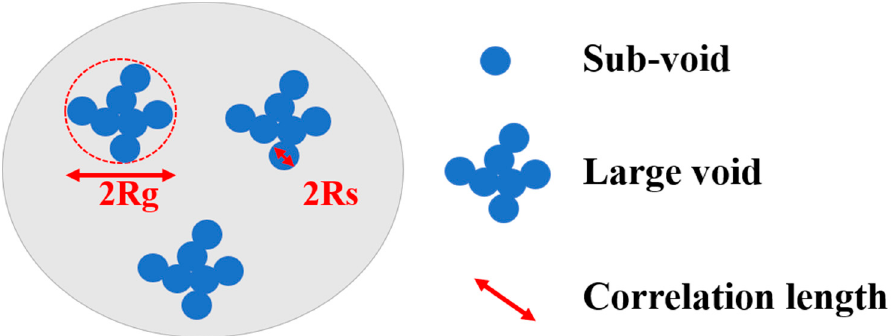
Figure 7. Voids composed of large voids with a radius of gyration for the entire void, R g , and a radius of gyration for the sub-voids, R s , are observed.